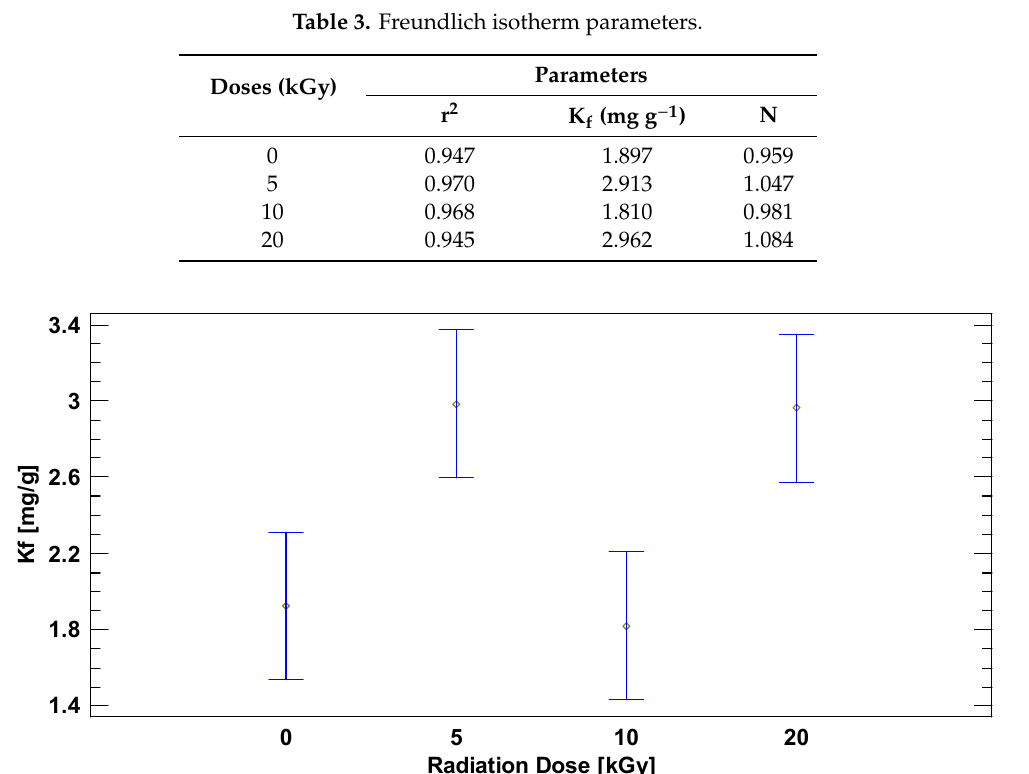
Figure 11. Statistical analysis of irradiation dose e ff ect on DB1 adsorption. (C O, DB1 = 50 mg L − 1 ; catalyst dose = 200 mg L − 1 ; pH o = 2.5; T amb ).